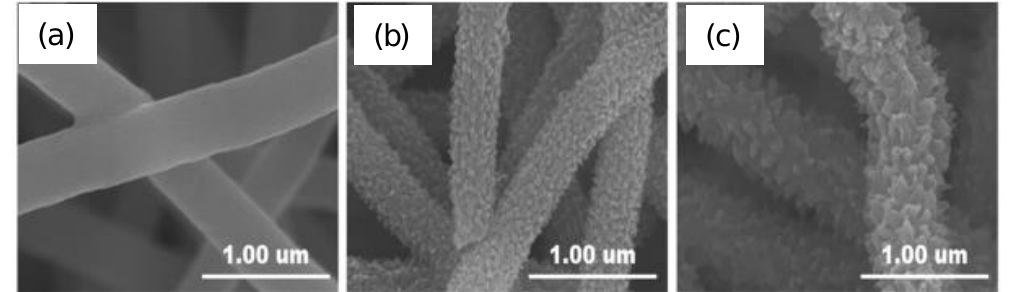
Figure 22. FE-SEM images of ( a ) carbonized C fibers, ( b ) polyaniline (PANI)-coated C fibers, and ( c ) PANI-coated C/CNTs fibers (reproduced from reference [185] with permission. Copyright 2017, Elsevier).